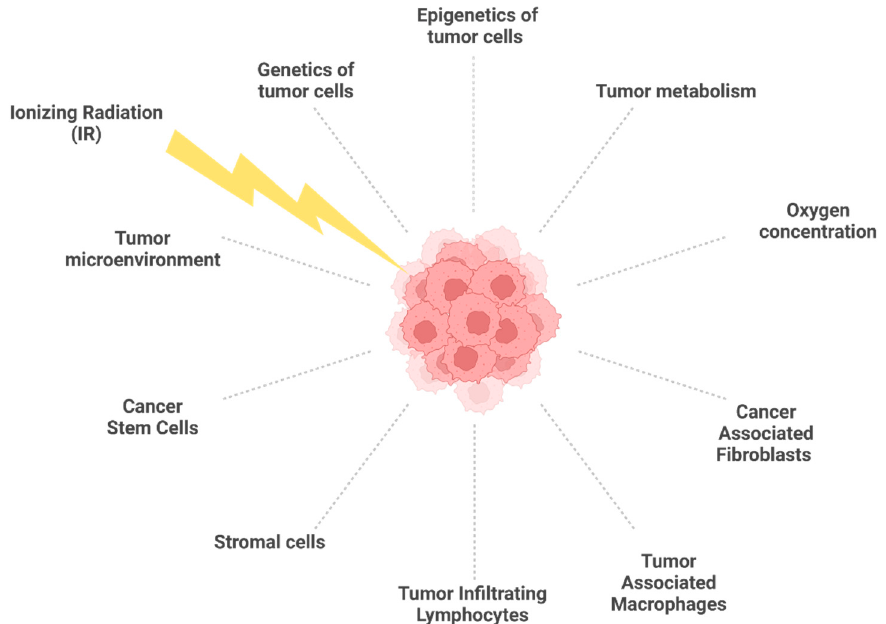
Figure 1. Biological factors affecting tumor radioresistance. In response to IR, the diverse components of the tumor microenvironment interact each other, with tumor cells contributing to radioresistance. Created with BioRender.